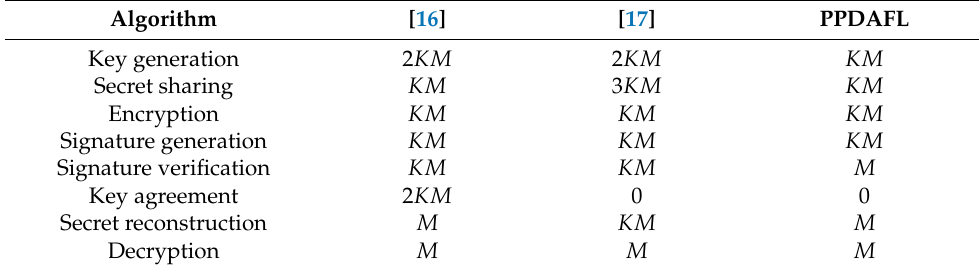
Table 3. Computational expense